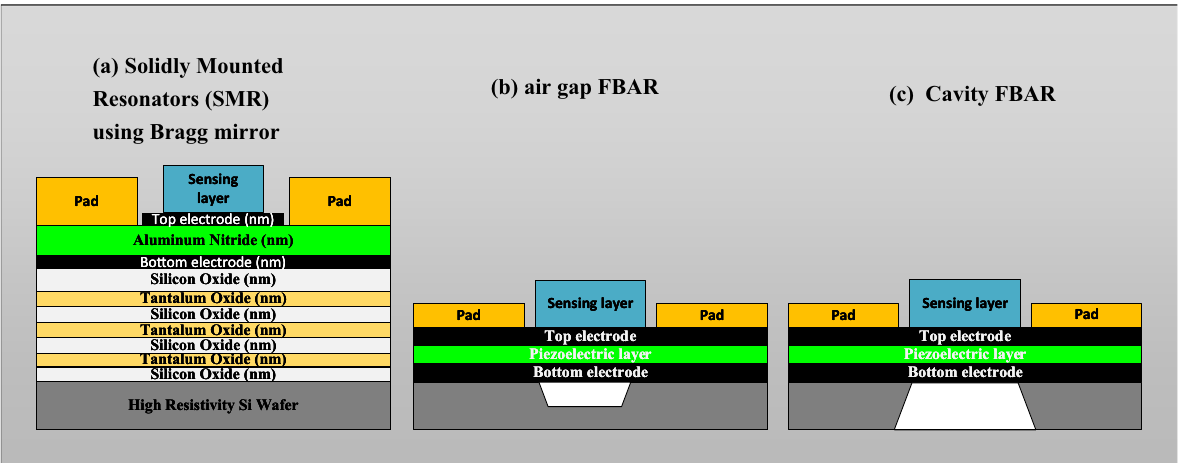
Fig. 12 Typical schematic of three different types of FBAR, ( a ) SMR based FBAR [348], ( b ) Air gap based FBAR [349], and ( c ) the Cavity based FBAR using back etch [244,